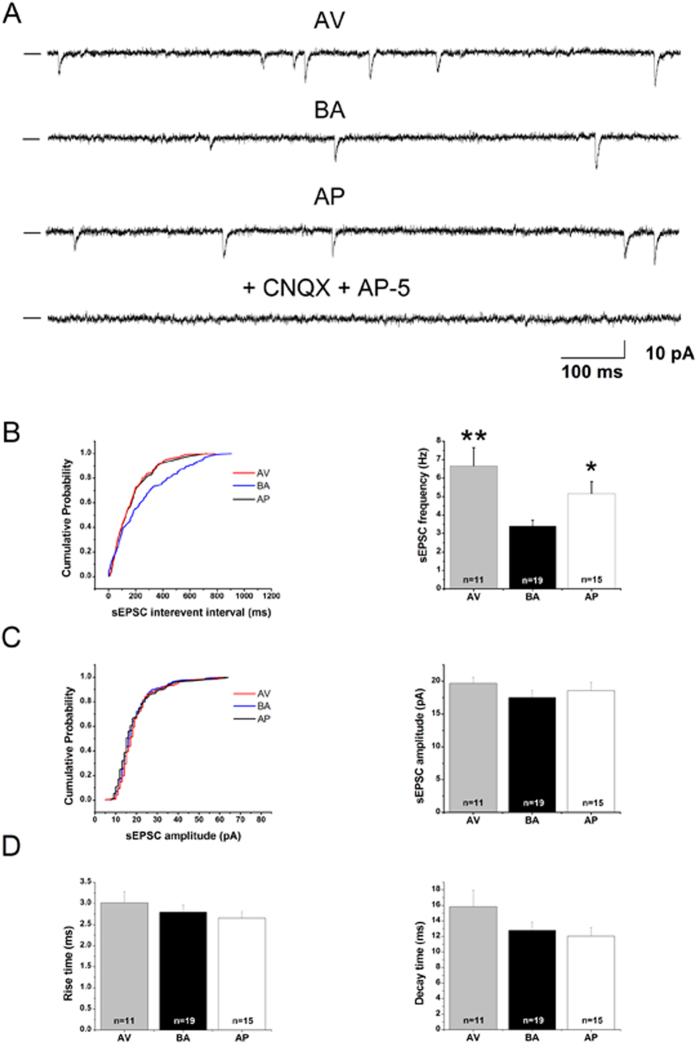
Prefrontal pyramidal neurons of avoiding (AV) and approaching (AP) animals show a significant increase in the spontaneous excitatory postsynaptic currents (sEPSCs) frequencies compared to neurons of balancing (BA) animals.(A) Representative traces of sEPSCs recorded from prefrontal pyramidal neurons of AV, AP and BA animals. In the presence of 6-cyano-7-nitroquinoxyline-2,3-dione (CNQX, 10 μM) and amino-5-phosphonovaleric acid (AP-5, 50 μM) ionotropic glutamatergic receptor antagonists, the excitatory synaptic activity was completely abolished. (B) On the left, cumulative probability plots of sEPSC inter-event intervals in pyramidal neurons of AP, AV and BA mice. In the AV and AP mice the inter-event intervals were significantly lower compared to those of BA mice (P < 0.05; K–S test). On the right, the sEPSC frequencies of pyramidal neurons of AV, AP and BA mice are reported. (C) On the left, cumulative probability plots of sEPSC amplitude in pyramidal neurons of AP, AV and BA mice (P > 0.05; K–S test). On the right, the sEPSC amplitudes of pyramidal neurons of AV, AP and BA mice are reported. (D) sEPSC rise time (left) and decay time (right) of pyramidal neurons of AV, AP and BA mice. **P < 0.01; *P < 0.05. Data are presented as means ± SEM. Numbers inside the bar plots indicate the number of pyramidal neurons recorded (at least 2–3 for each AV, BA and AP animal).